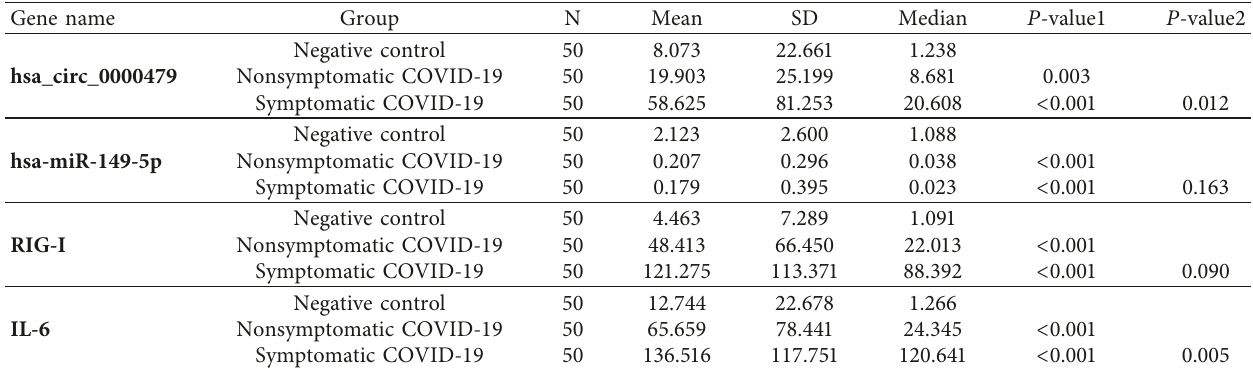
Table 4: The expression levels of hsa_circ_0000479, hsa-miR-149-5p, IL-6, and RIG-I in negative controls, nonsymptomatic COVID-19, and symptomatic COVID-19 patients ( P values 1: in comparison with negative control, 2: in comparison with nonsymptomatic COVID-19). Gene